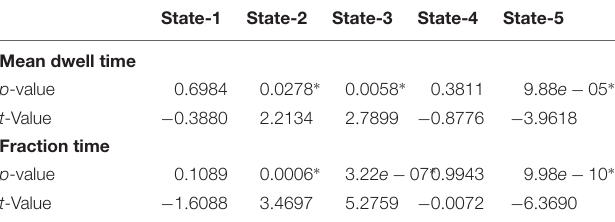
TABLE 1 | Two t -test mean dwell time and fraction time results showing Healthy control (HC) and Schizophrenia (SZ) differences in each